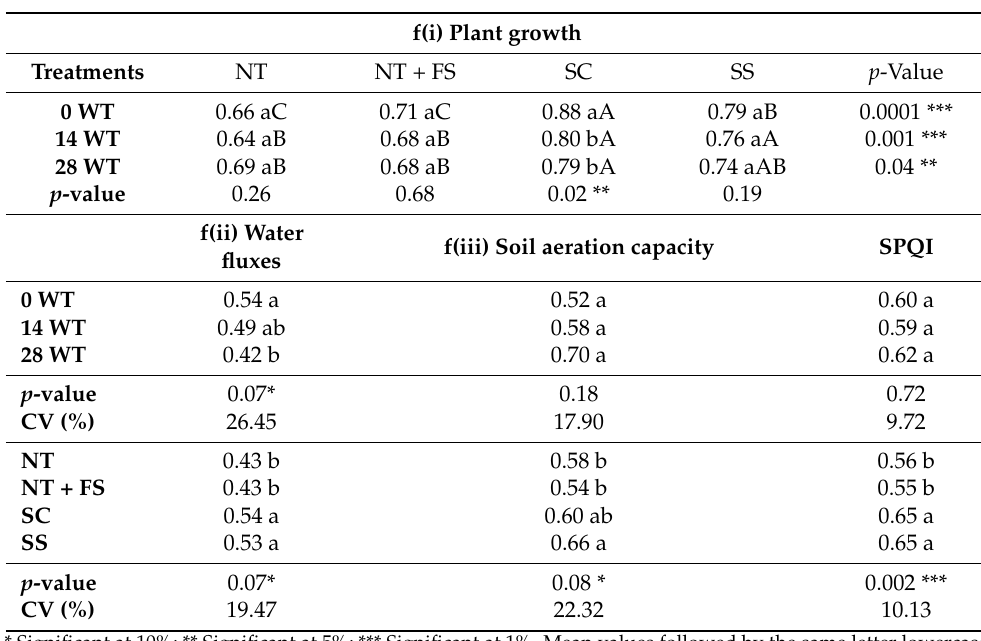
Table 6. Soil physical functions and soil physical quality index (SPQI) for the wheel-traffic and mechanical interventions for depth of 0.05–0.15